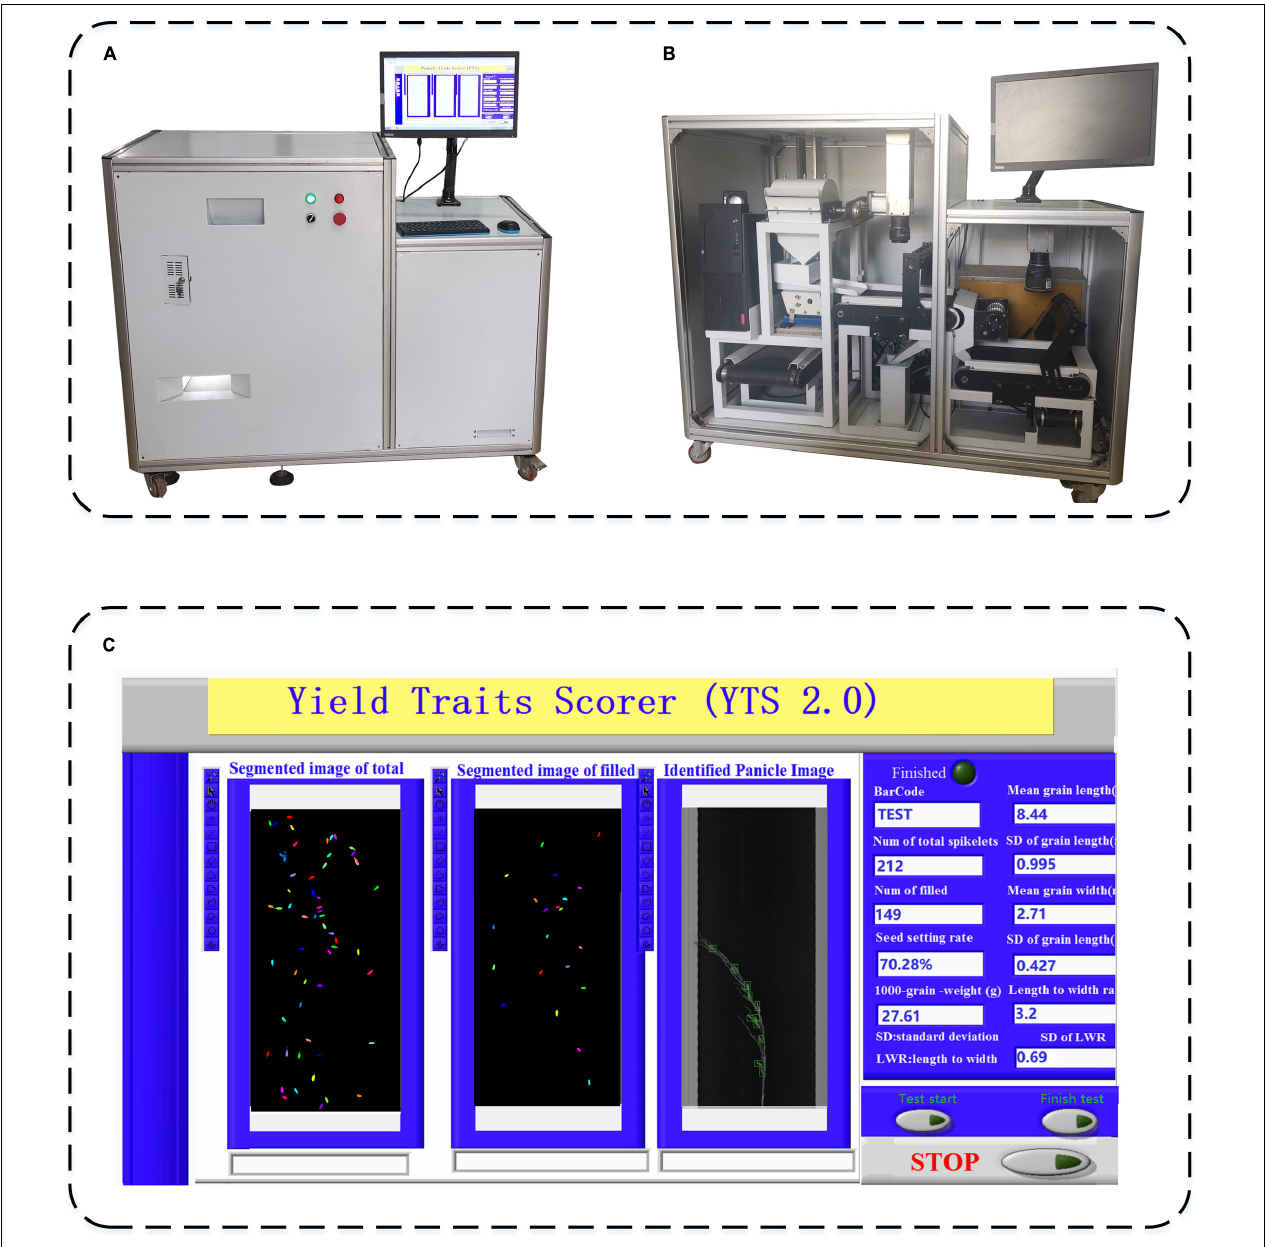
FIGURE 6 | The prototype of an automatic rice yield-related trait evaluation system, (A) system hardware composition, (B) system internal structure, and (C) system software interface.